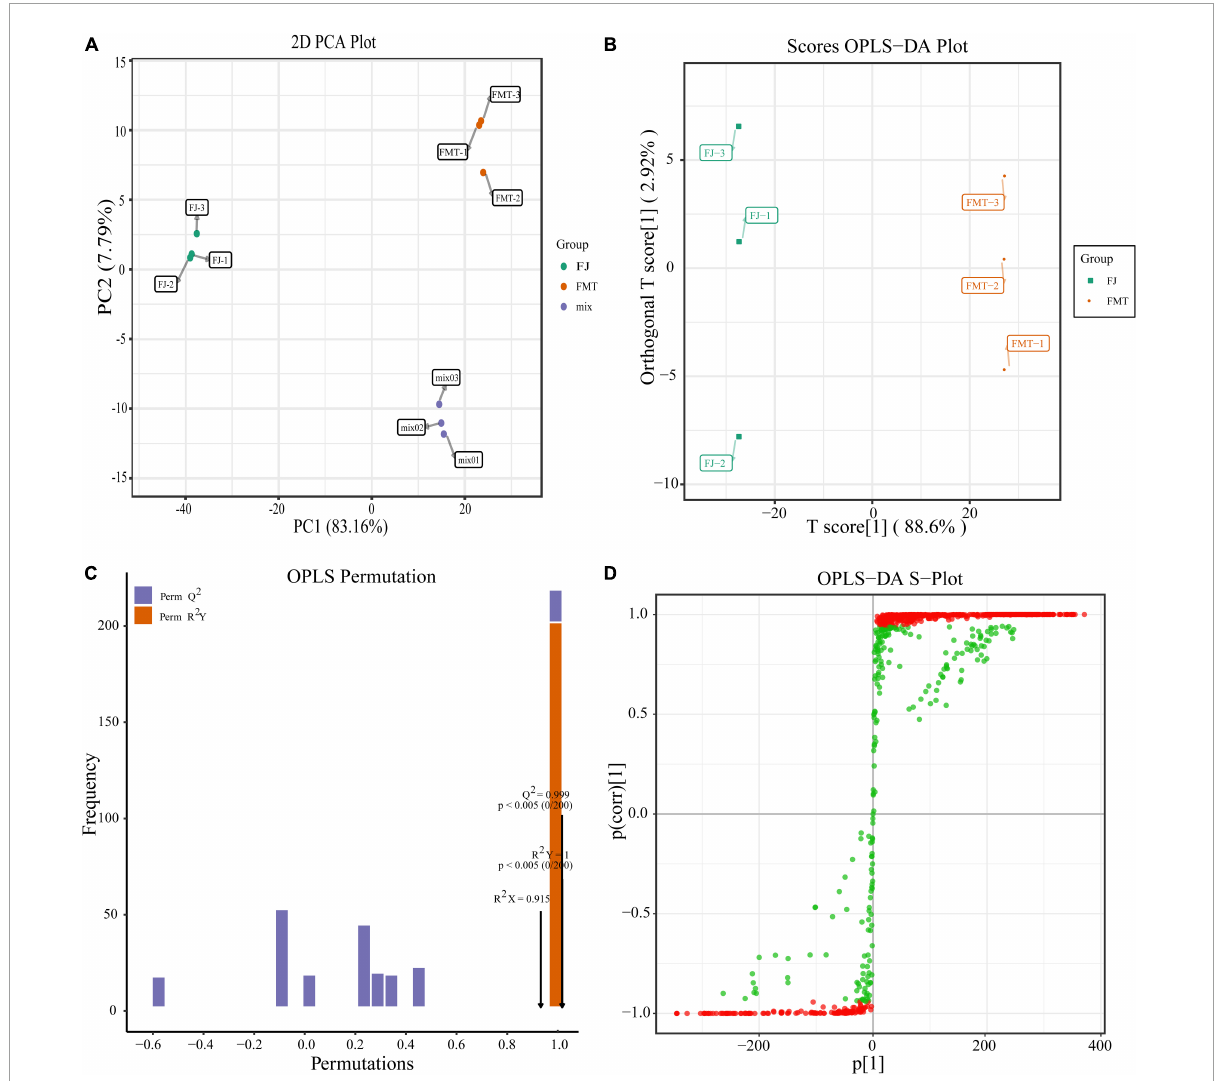
FIGURE2 Multivariate analysis of identified metabolites. (A) PCA analysis of metabolites identified from FJ and FMT. Equal volumes of FJ and FMT samples were mixed as a quality control (QC). (B) OPLS-DA model plot of the metabolites identified from FJ and FMT. (C) Permutation test for OPLS-DA model validation of FJ and FMT. (D) OPLS-DA S-Plot of the